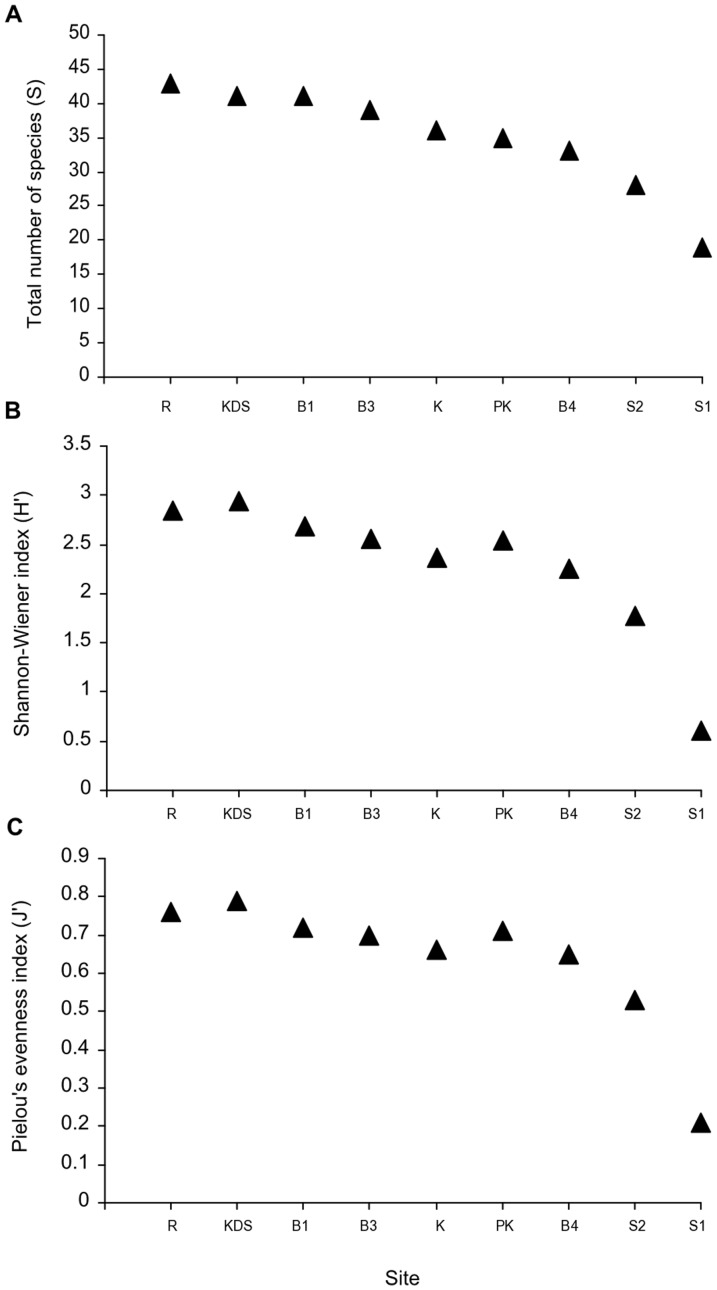
Sponge species diversity.Species diversity measures: a) total number of species; b) Shannon-Wiener index (H') c) Pielou's evenness index (J').